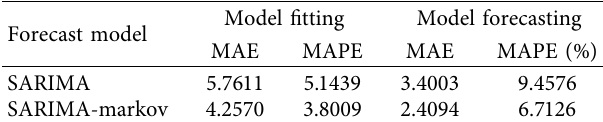
Table 6: Model test list (in million tons).